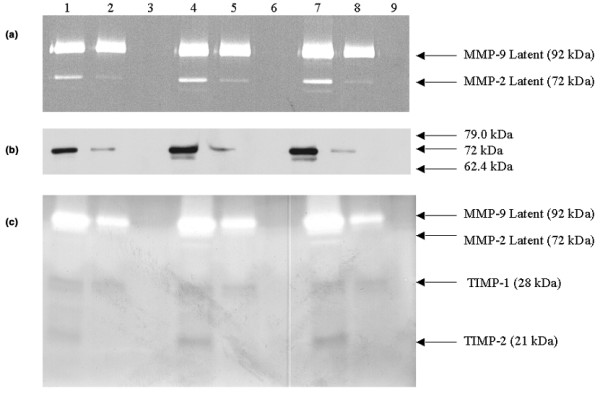
The effects of MDA-MB-231 breast adenocarcinoma CM on MMP and TIMP activity from THP-1 monocytes. (a) Gelatin zymogram and (b) MMP-2 immunoblot showing the upregulation of monocyte MMP-2 after exposure to MDA-MB-231 CM, and (c) a reverse zymogram to show that the activity of monocyte TIMP-2 was also upregulated upon exposure to MDA-MB-231 CM, although TIMP-1 activity remained the same upon treatment. Lanes 1, 4, and 7 contain CM from THP-1 cells in serum-free media grown in the presence of 100 μl, 200 μl and 300 μl concentrated MDA-MB-231 CM, respectively. Lanes 2, 5, and 8 contain CM from THP-1 cells in serum-free media grown in the presence of 100 μl, 200 μl and 300 μl concentrated serum-free media, respectively. Lanes 3, 6, and 9 contain serum-free media with 100 μl, 200 μl and 300 μl, respectively, of MDA-MB-231 CM in the absence of THP-1 cells. These figures are representative of three independent experiments carried out in duplicate, each of which demonstrates similar results.